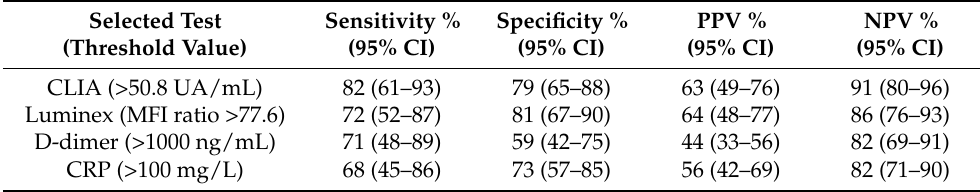
Table 3. Diagnostic performances of the selected tests to discriminate severely ill